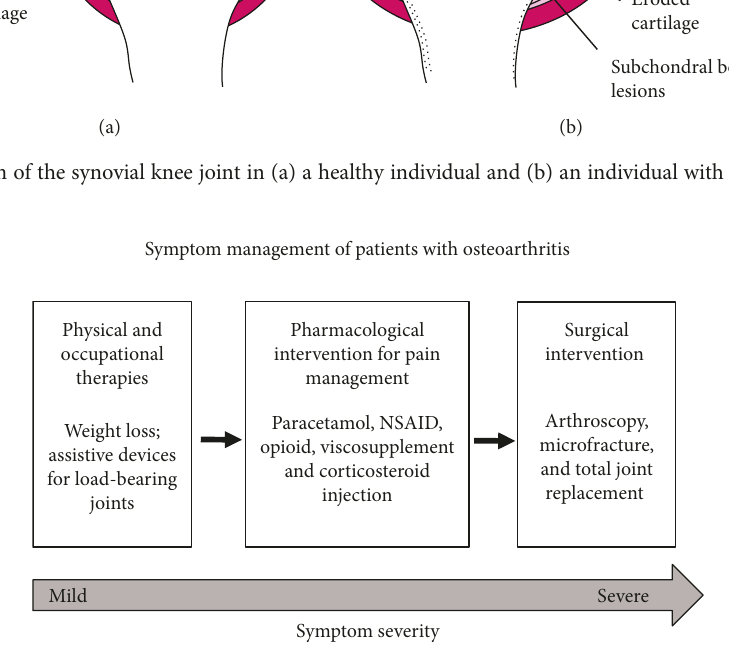
Figure 2: Current recommended treatment modalities for osteoarthritis (source: Arden et al.